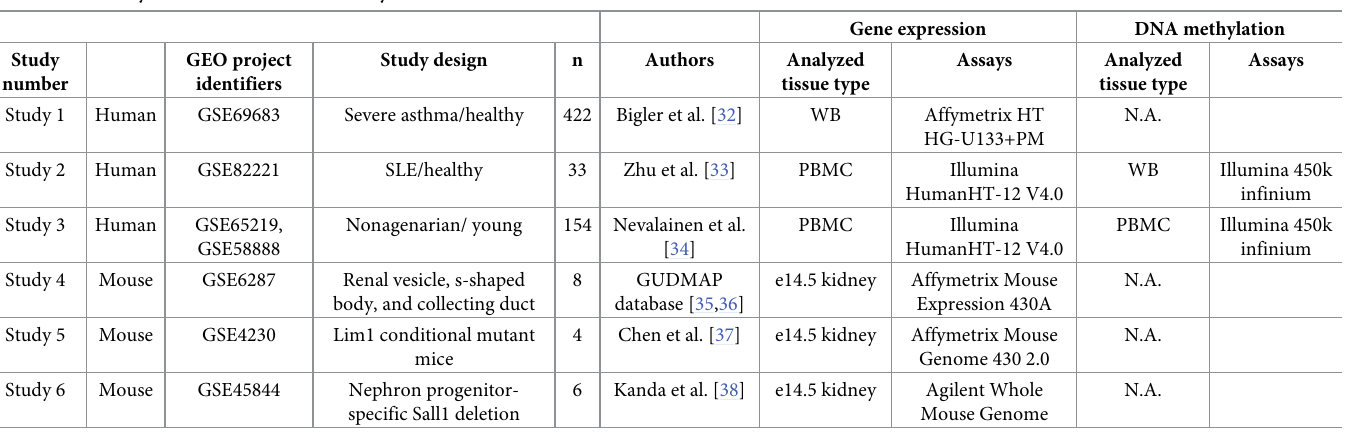
Table 1. Summary of datasets used in this